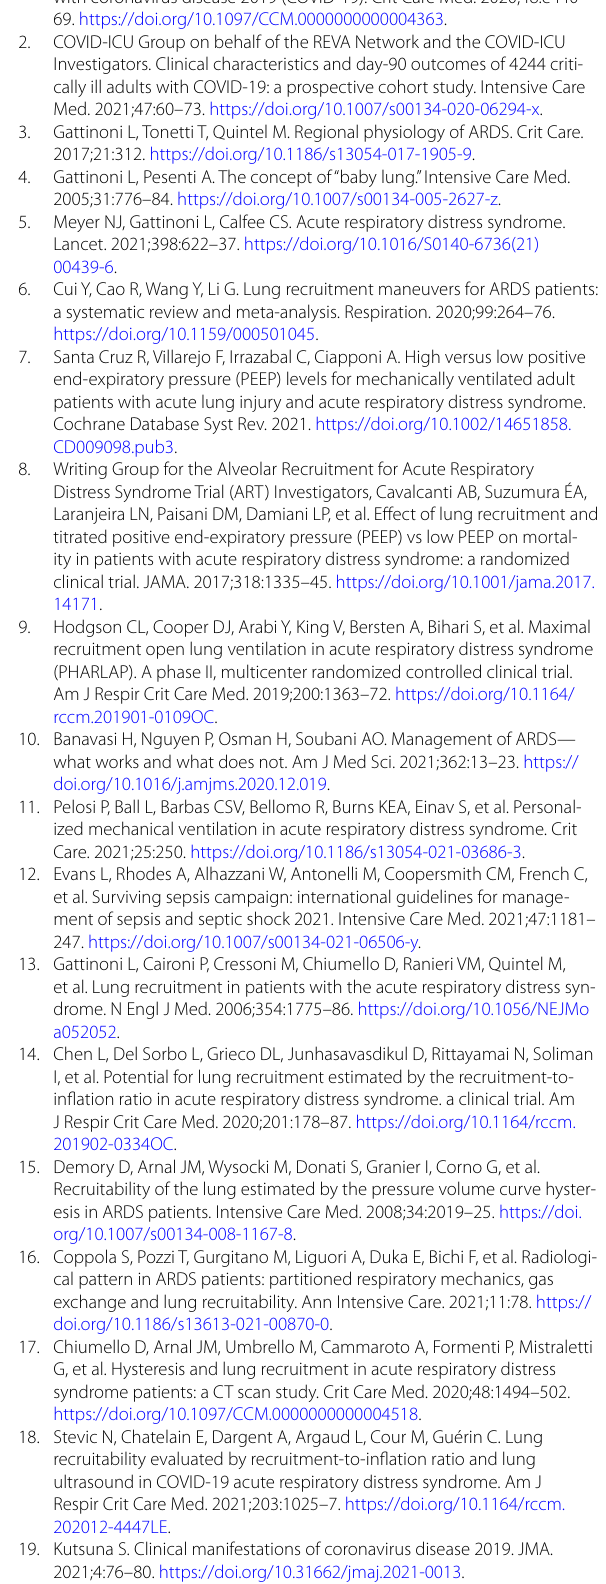
23, rho 0.80 [95% CI = =